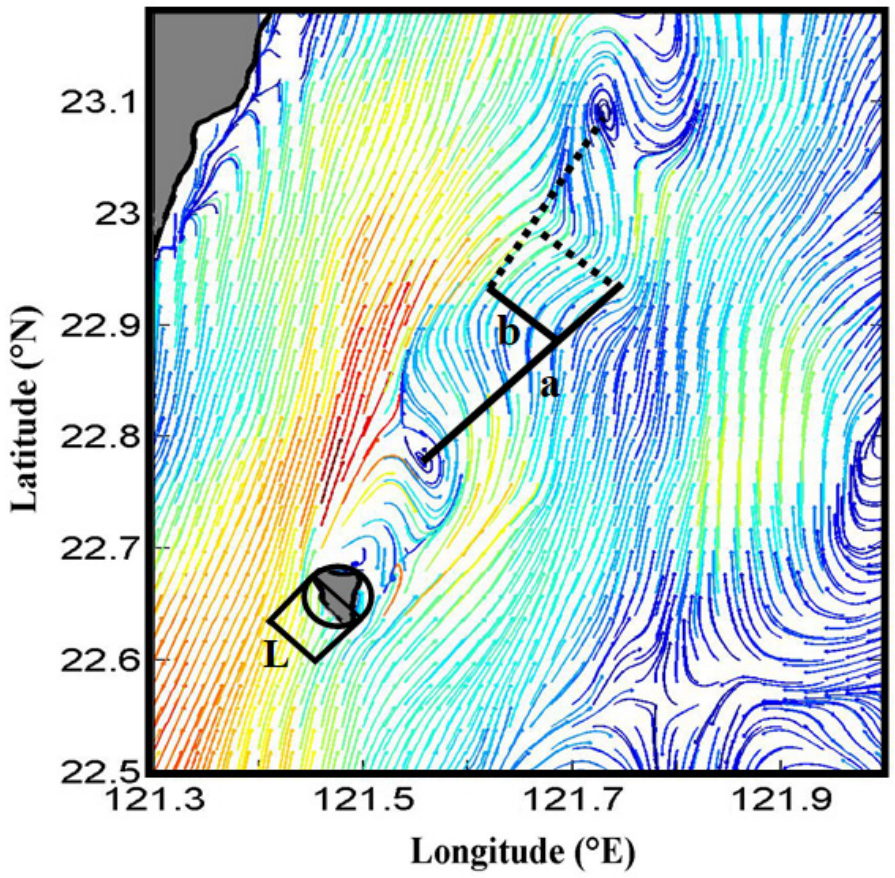
Figure 18. Schematic diagram for several definitions of vortex